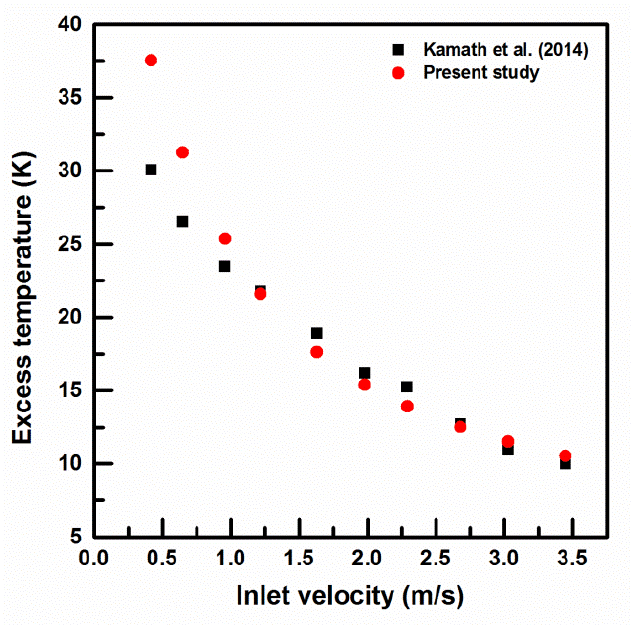
Figure 3. Variation of bottom heater